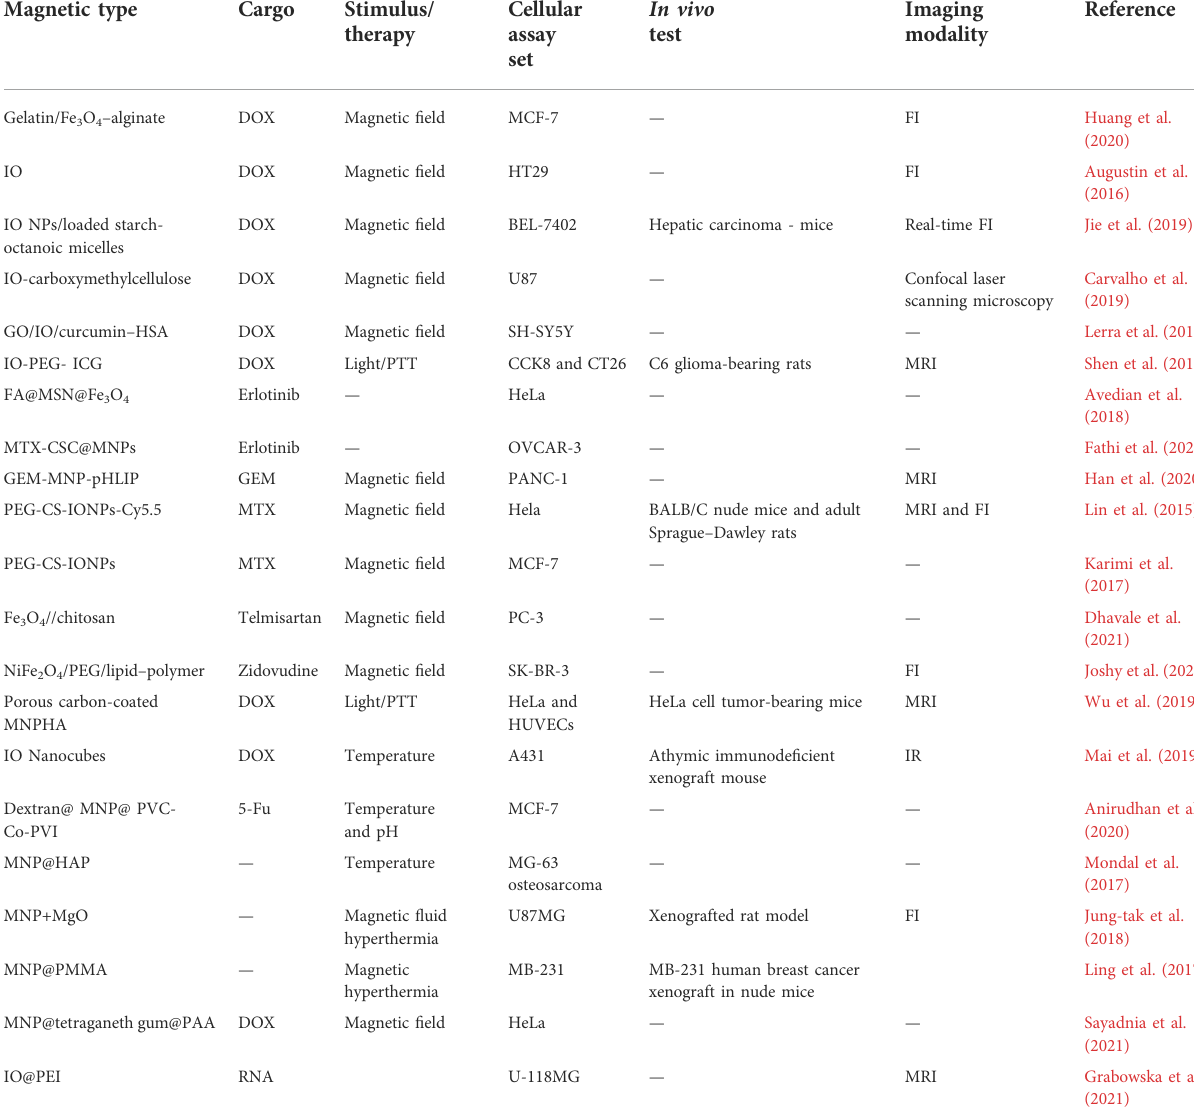
TABLE 4 Physically triggered MNP concerning the type of stimulus and cargo for in vitro and in vivo investigation, therapy, and